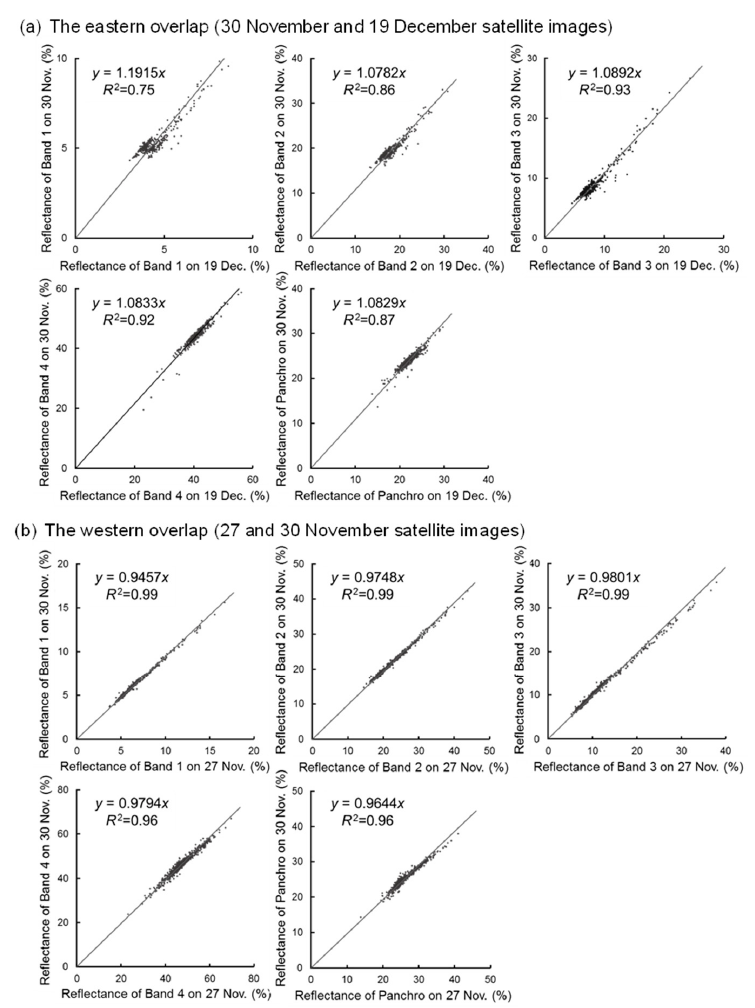
Figure 4. The relationships between reflectance in each band for two different combinations of dates that represent the eastern and western overlaps (Figure 1b). All regressions were significant at p < 0.01.